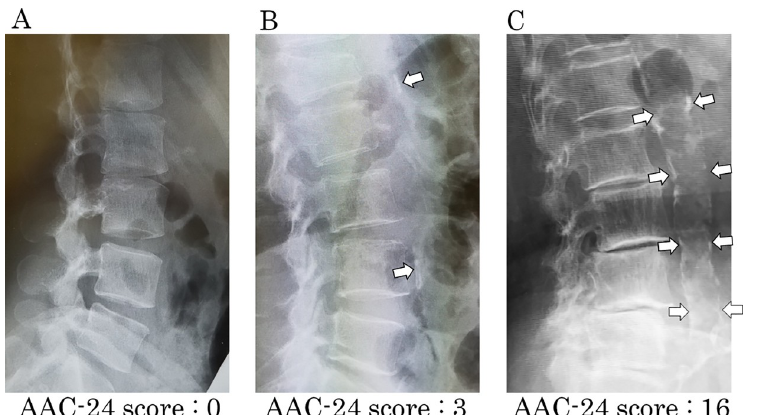
Fig 2. Radiographic images with (A) no abdominal aortic calcification (AAC), (B) moderate AAC (AAC-24 score = 4), and (C) moderate AAC (AAC-24 score = 16). AAC is indicated by white arrows.